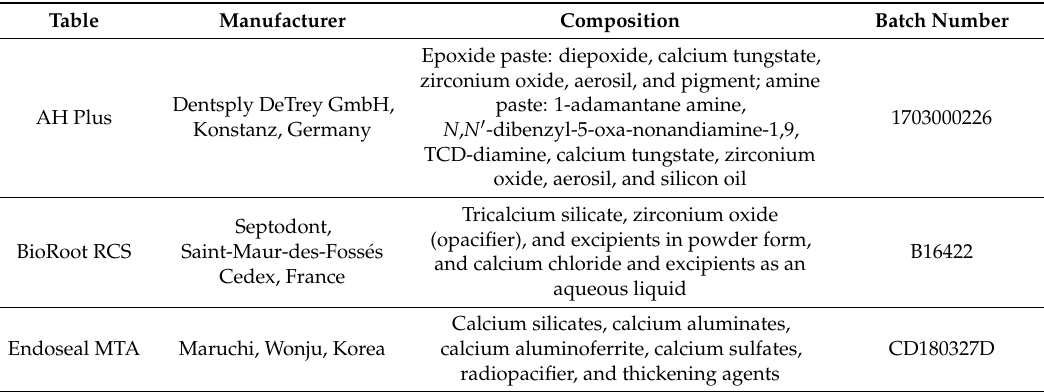
Table 1. Manufacturers and chemical compositions of experimental sealers.